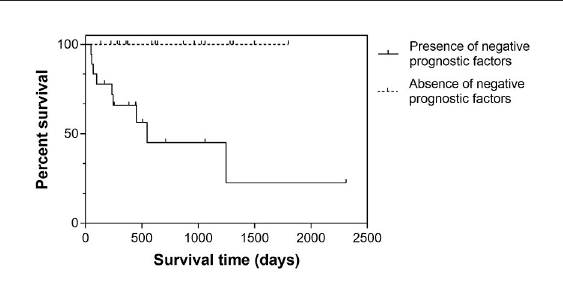
FIGURE3 Kaplan-Meier survival curves in 37 dogs with splenic nodular lesions composed of a mixed stromal, histiocytic and lymphoid population. Cases were stratified according to the presence or absence of negative histologic prognostic factors (i.e., stromal cell atypia and at least one of MC ≥ 9, presence of karyomegaly/multinucleated cells, and lymphoid component <